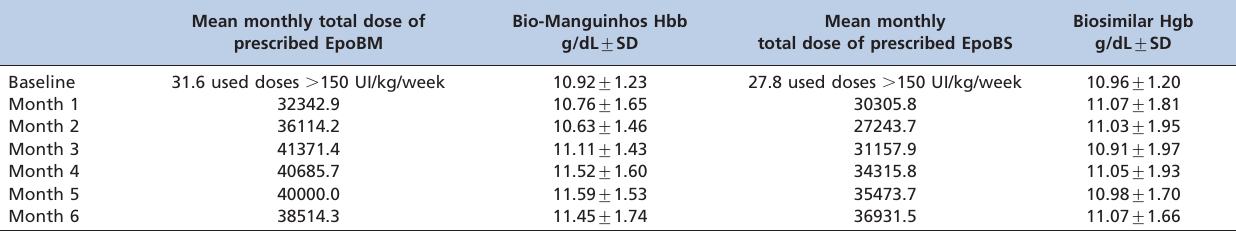
Table 2 - Epoetin alfa dose used and hemoglobin values (mean ¡ SD) by patient